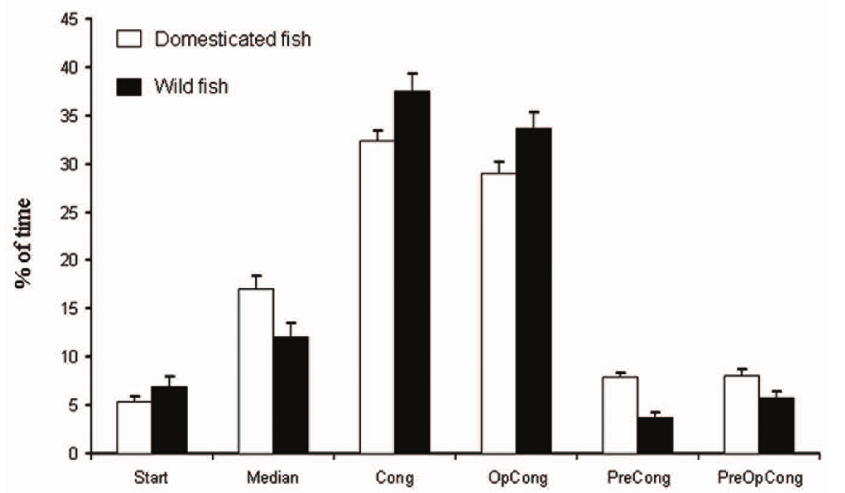
Figure 2. Proportion of time spent (mean ± S.E., in %) by a fish in each zone of the maze. Start : Start Box, Median: Median area, Cong: reward zone near the congener, OpCong: zone opposite to the reward zone, PreCong: zone located between Median and Cong, PreOpCong: zone located between Median and OpCong.